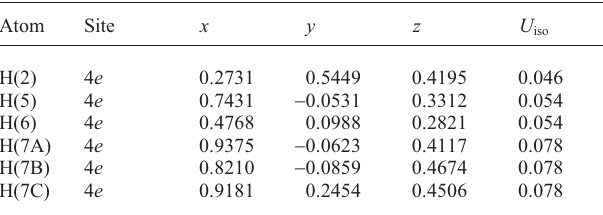
Table 2. Atomic coordinates and displacement parameters (in Å 2 )